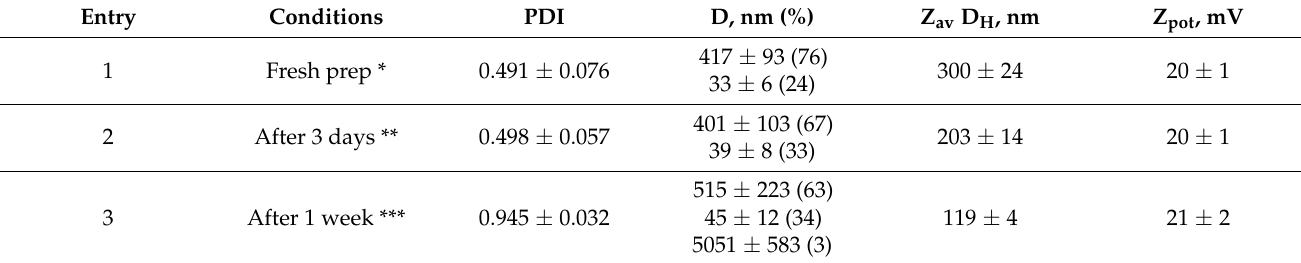
Table 1. Values of polydispersity index (PDI), diameter of populations (D), Z -average diameter (Z av ) and zeta-potential (Z pot ) of nanoparticles formed by 1,4-DHP amphiphile 4 obtained by DLS measurements. The PDI value describes polydispersity of the sample; diameter of populations shows size of each fraction of nanoparticles, the Z -average diameter represents the average hydrodynamic diameter of all nanoparticles in the sample; the zeta-potential gives information about the surface charge of nanoparticles. The final concentration of the compound was 0.125